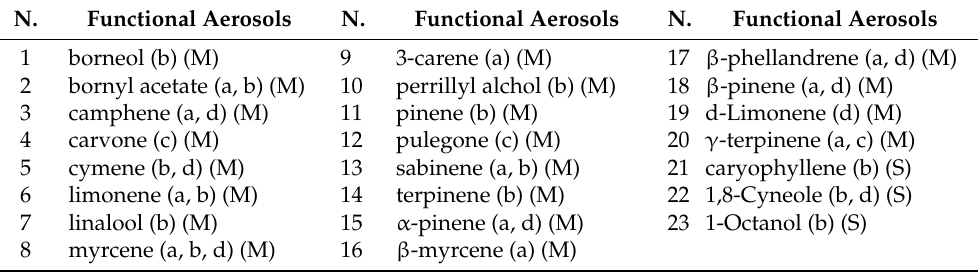
Table 2. BVOC emission potentials of leaves and needles of selected major European forest tree species. N. Functional Aerosols N. Functional Aerosols N. Functional